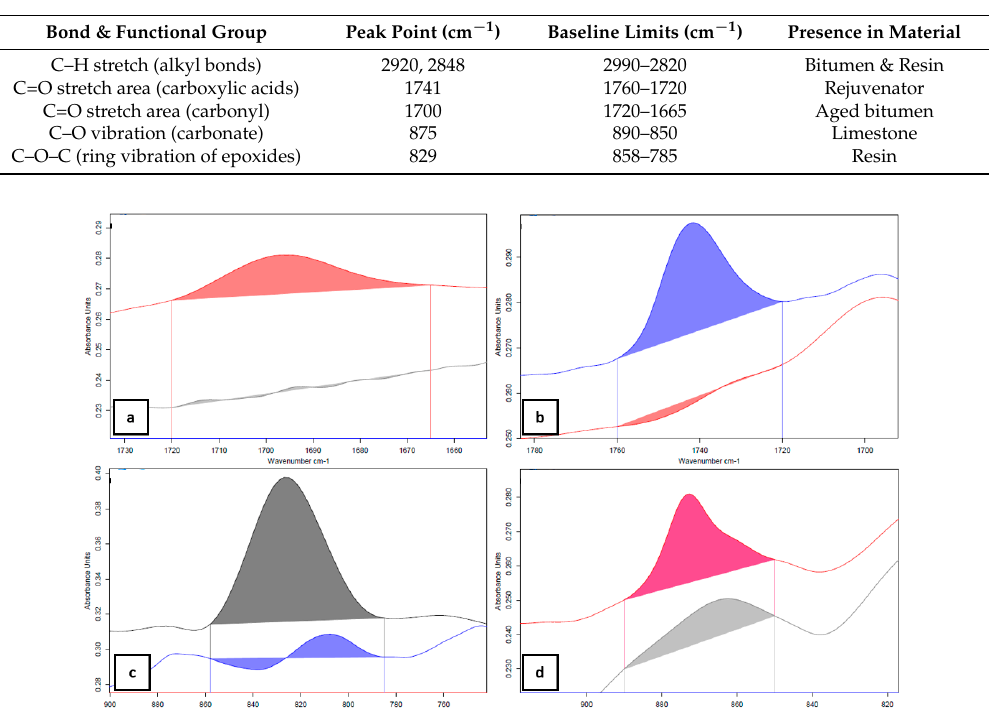
Table 3. Distinctive bands of the individual components.